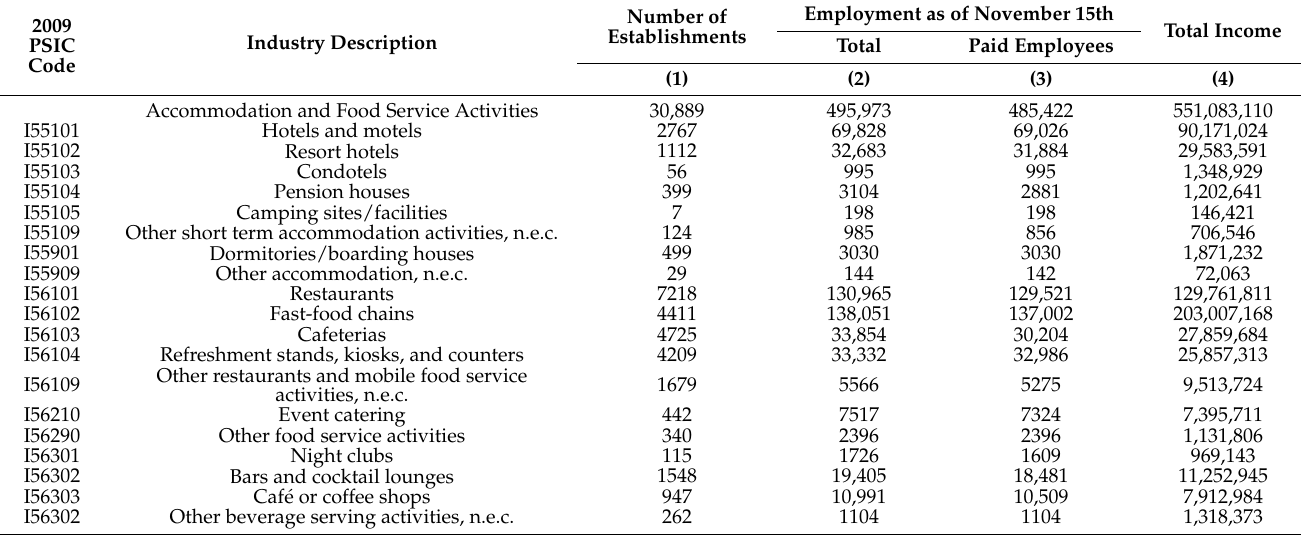
Table 1. Accommodation and food service activities establishments by industry in the Philippines,